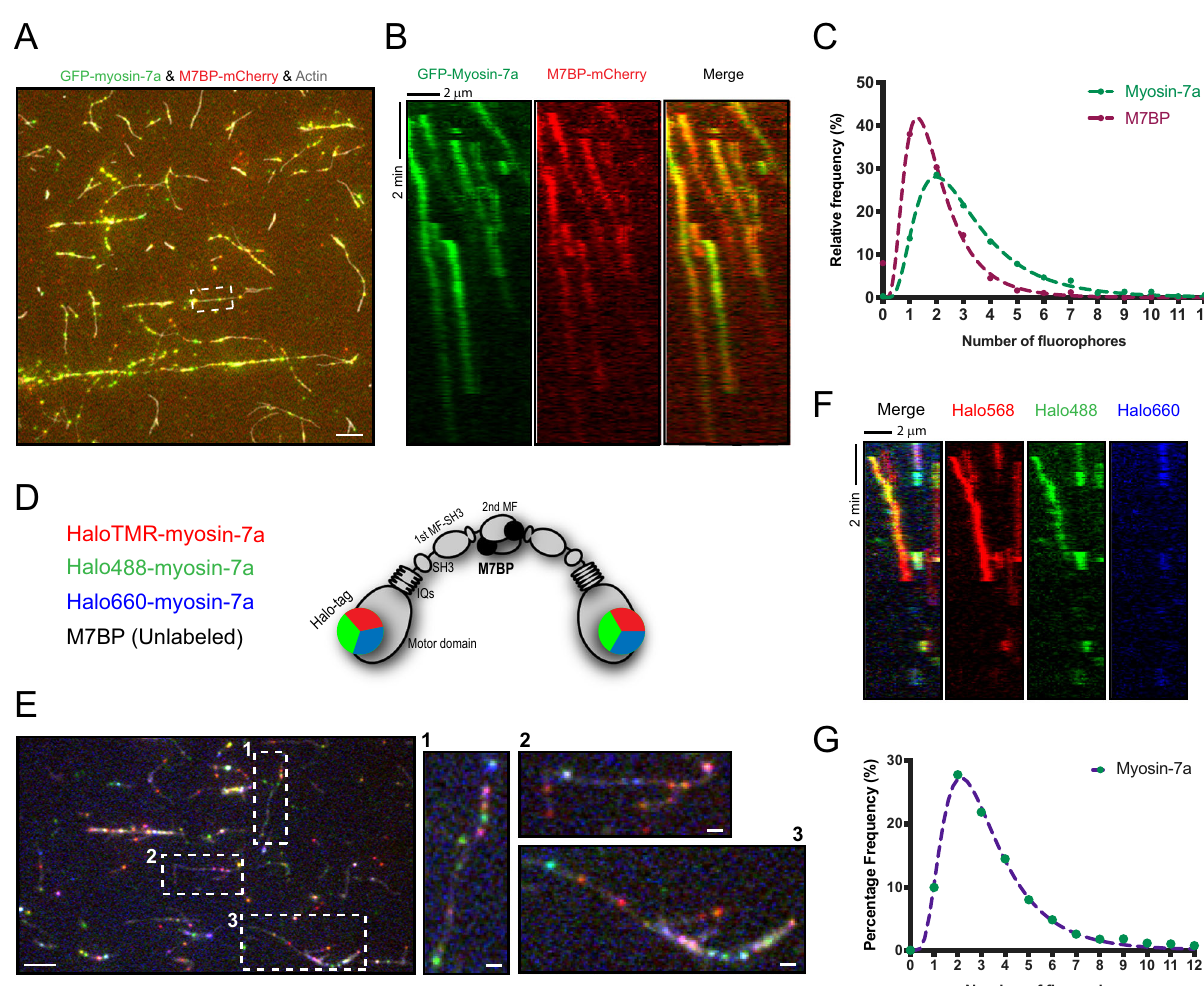
Fig. 3 Processive myosin-7a complexes are predominantly dimeric. A TIRF view of single-molecule motility assays with mCherry-tagged M7BP demonstrates that GFP-myosin-7a (green) and M7BP-mCherry (red) are colocalized in the majority of the puncta moving along actin fi laments. Actin fi laments were labeled with Alexa-Fluor 647 phalloidin (gray). Scale bar = 5 μ m. B Kymograph analysis of box in A shows that the processive movements (diagonal lines) of GFP-myosin-7a and M7BP-mCherry are overlaid. C The histograms of fl uorophore numbers (GFP for myosin-7a and mCherry for M7BP) determined by fl uorescence intensity analysis. N = 661 quanti fi ed complexes. D Schematic of the three-color labeling experiments to test the hypothesis that the motile complex is composed of dimerized myosin-7a. Halo-tagged myosin-7a was labeled with TMR (red), Alexa-Fluor 488 (green), or Alexa- Fluor 660 (blue) and equal quantities of all three labeled myosins were simultaneously introduced into the fl ow chamber. E Movie frames show that myosin-7a labeled with three different colors moves processively along actin with low motor unit numbers (as most puncta exhibit the original or a mixture of two colors). Actin is labeled with Alexa-Fluor 405 phalloidin and displayed in gray). Unlabeled M7BP is present at the concentration equal to that of total myosin-7a. Images 1, 2, and 3 correspond to the regions in box 1, 2, and 3 at particular time points. Scale bar = 5 μ m (left panel); Scale bar = 1 μ m in images of 1, 2, and 3. F Kymograph analysis of the three-color single-molecule assays showing examples of different-color fl uorophores moving together. G Frequency distribution histogram of the numbers of HaloTag fl uorophores in each complex indicating that the motile complexes predominantly contain two myosin molecules. N = 1485 quanti fi ed